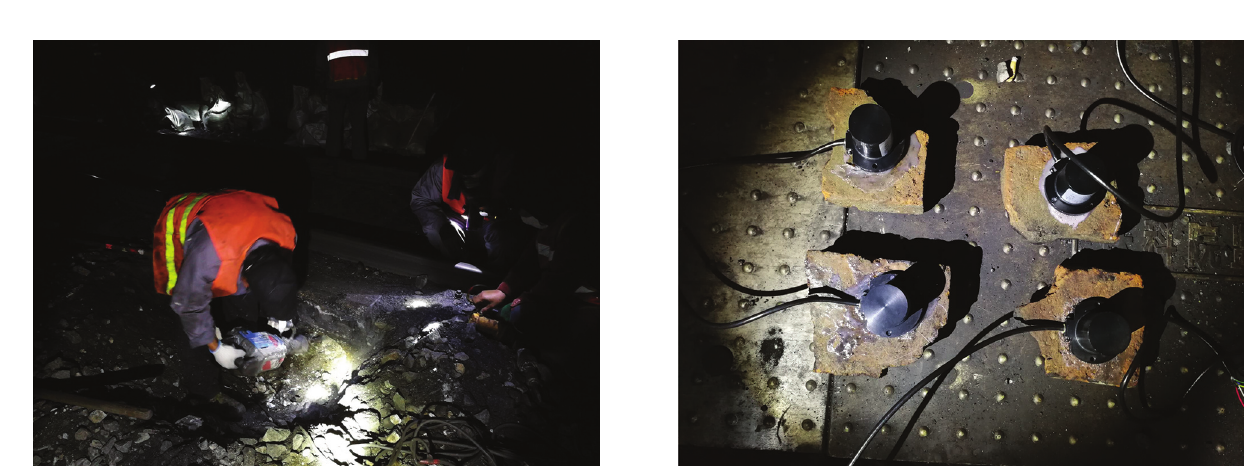
Figure 1: Layout of tunnel dynamic test points.